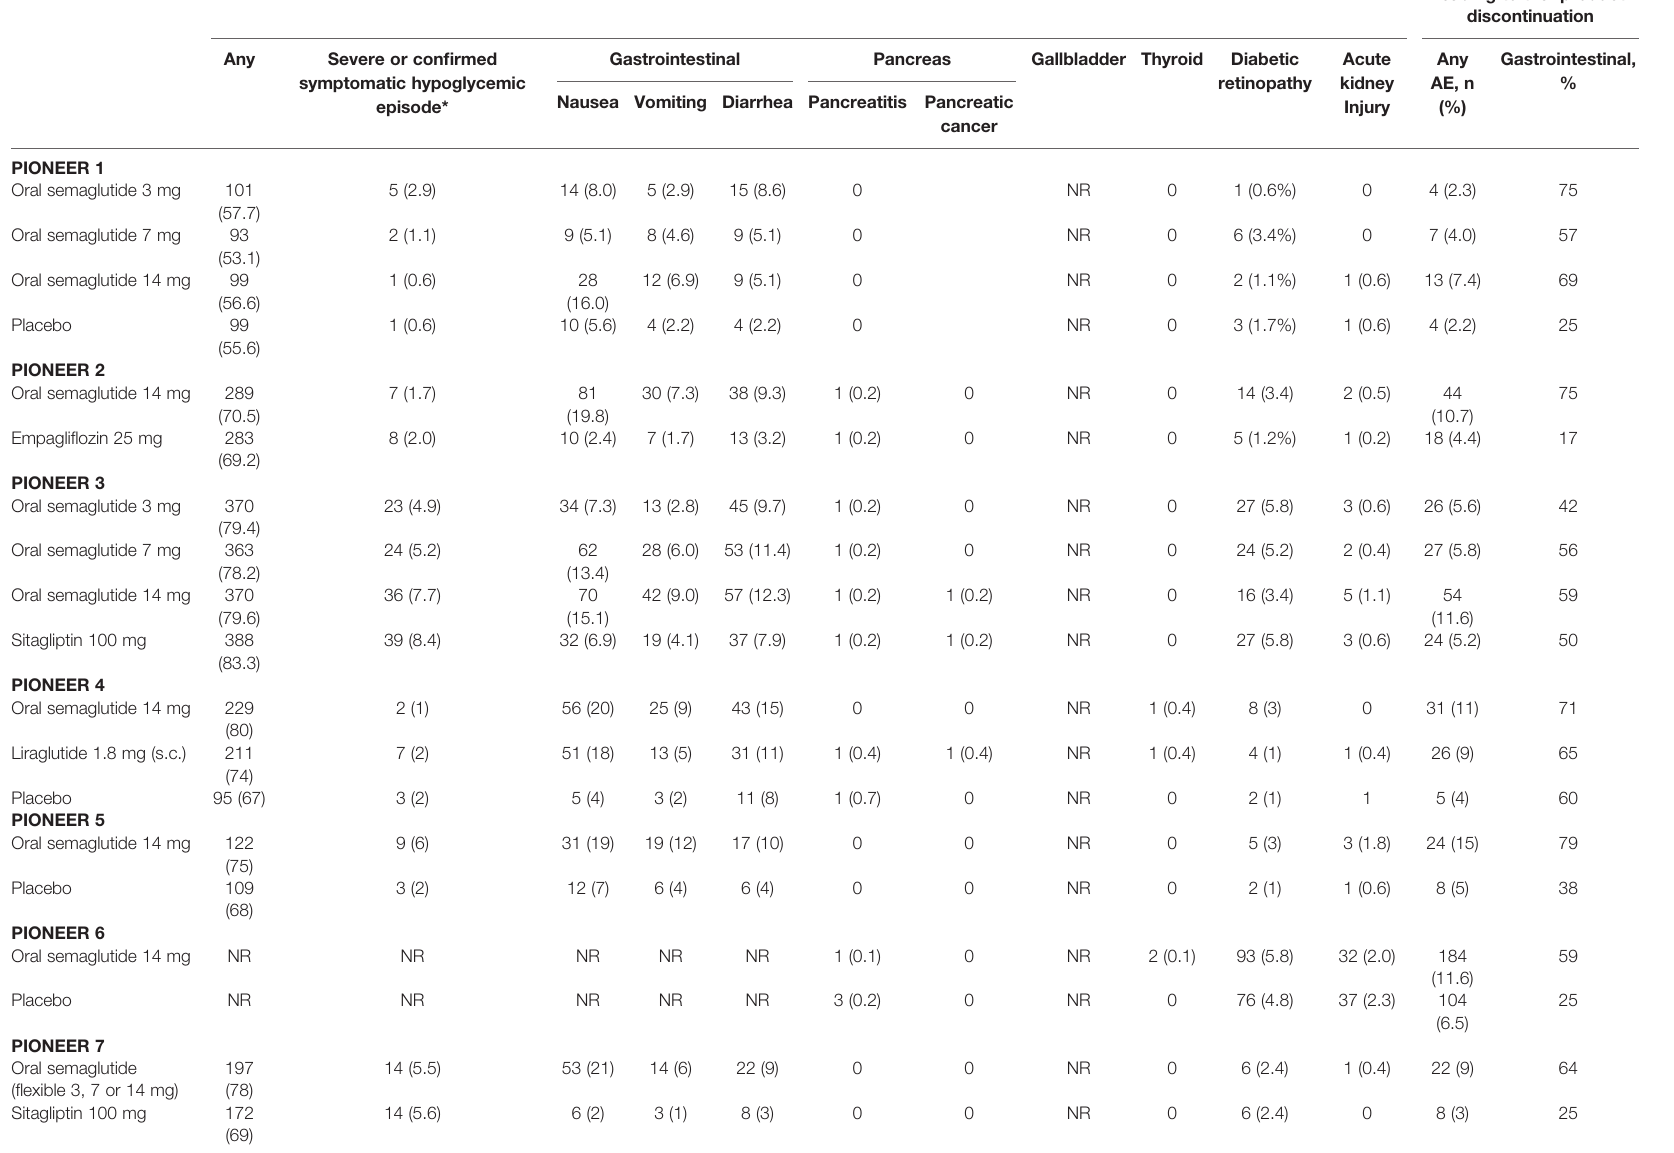
TABLE 2 | Adverse effects and safety risks in phase 3 trials (10 –